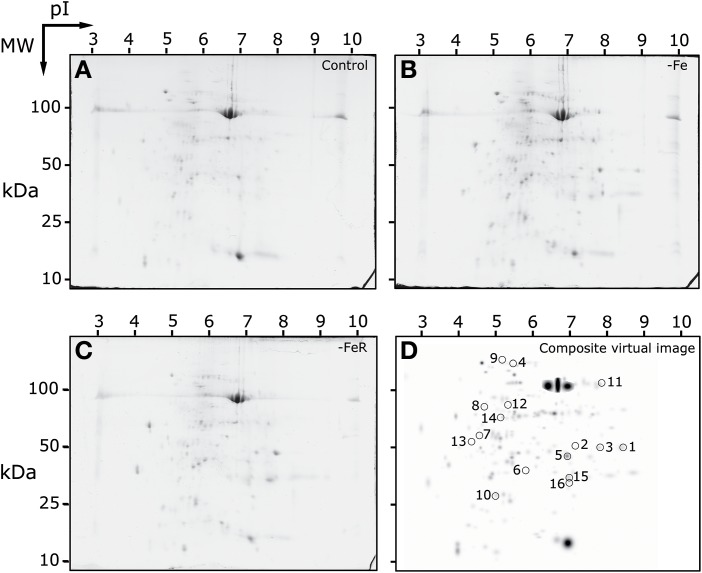
2-DE IEF-SDS PAGE protein profile maps of leaf apoplastic fluid extracts from sugar beet plants. Scans of typical gels from Fe-sufficient (+Fe), Fe-deficient (−Fe) and Fe-resupplied Fe-deficient (−FeR) plants are shown in (A–C), respectively. To facilitate visualization of the studied spots, a virtual composite image (D) was created containing all spots present in the real gels (A–C). In (D) spots whose intensities changed in relative abundance as a result of the treatments are circled and numbered as in Table 2.